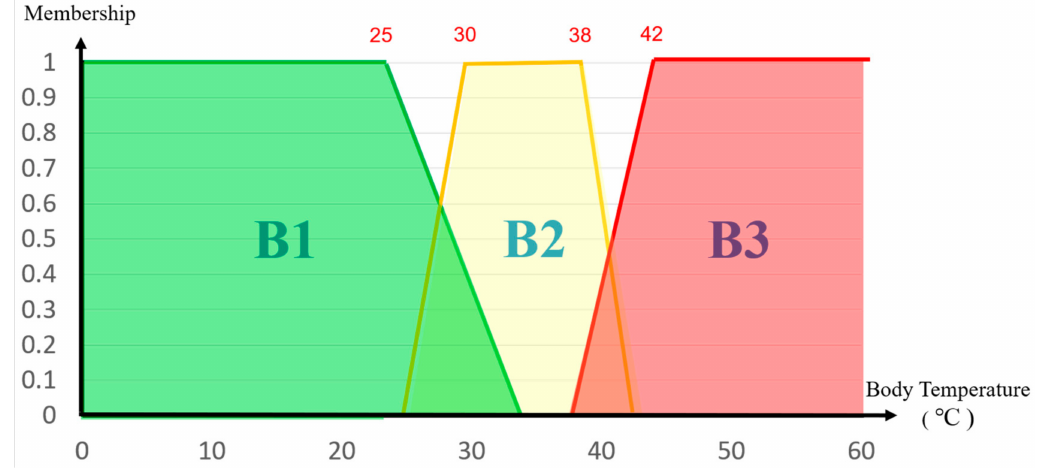
Figure 11. Fuzzy set domain of body temperature.